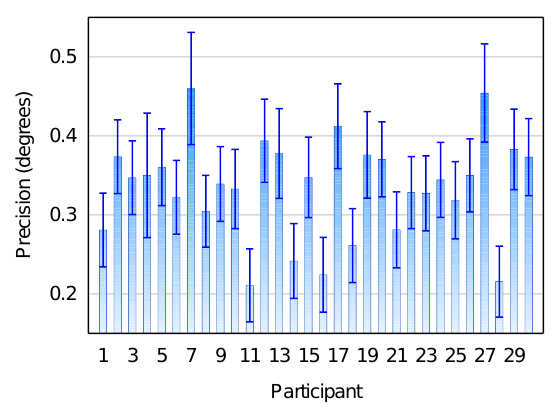
Figure 6: Average precision per participant at 100 Hz in the centre of the head box. Vertical bars denote 95% confi- dence